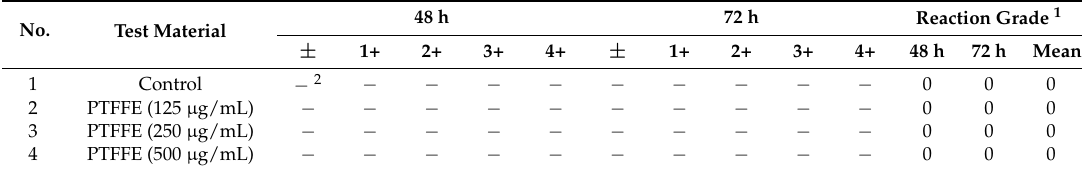
Table 1. Results of the human skin primary irritation test.